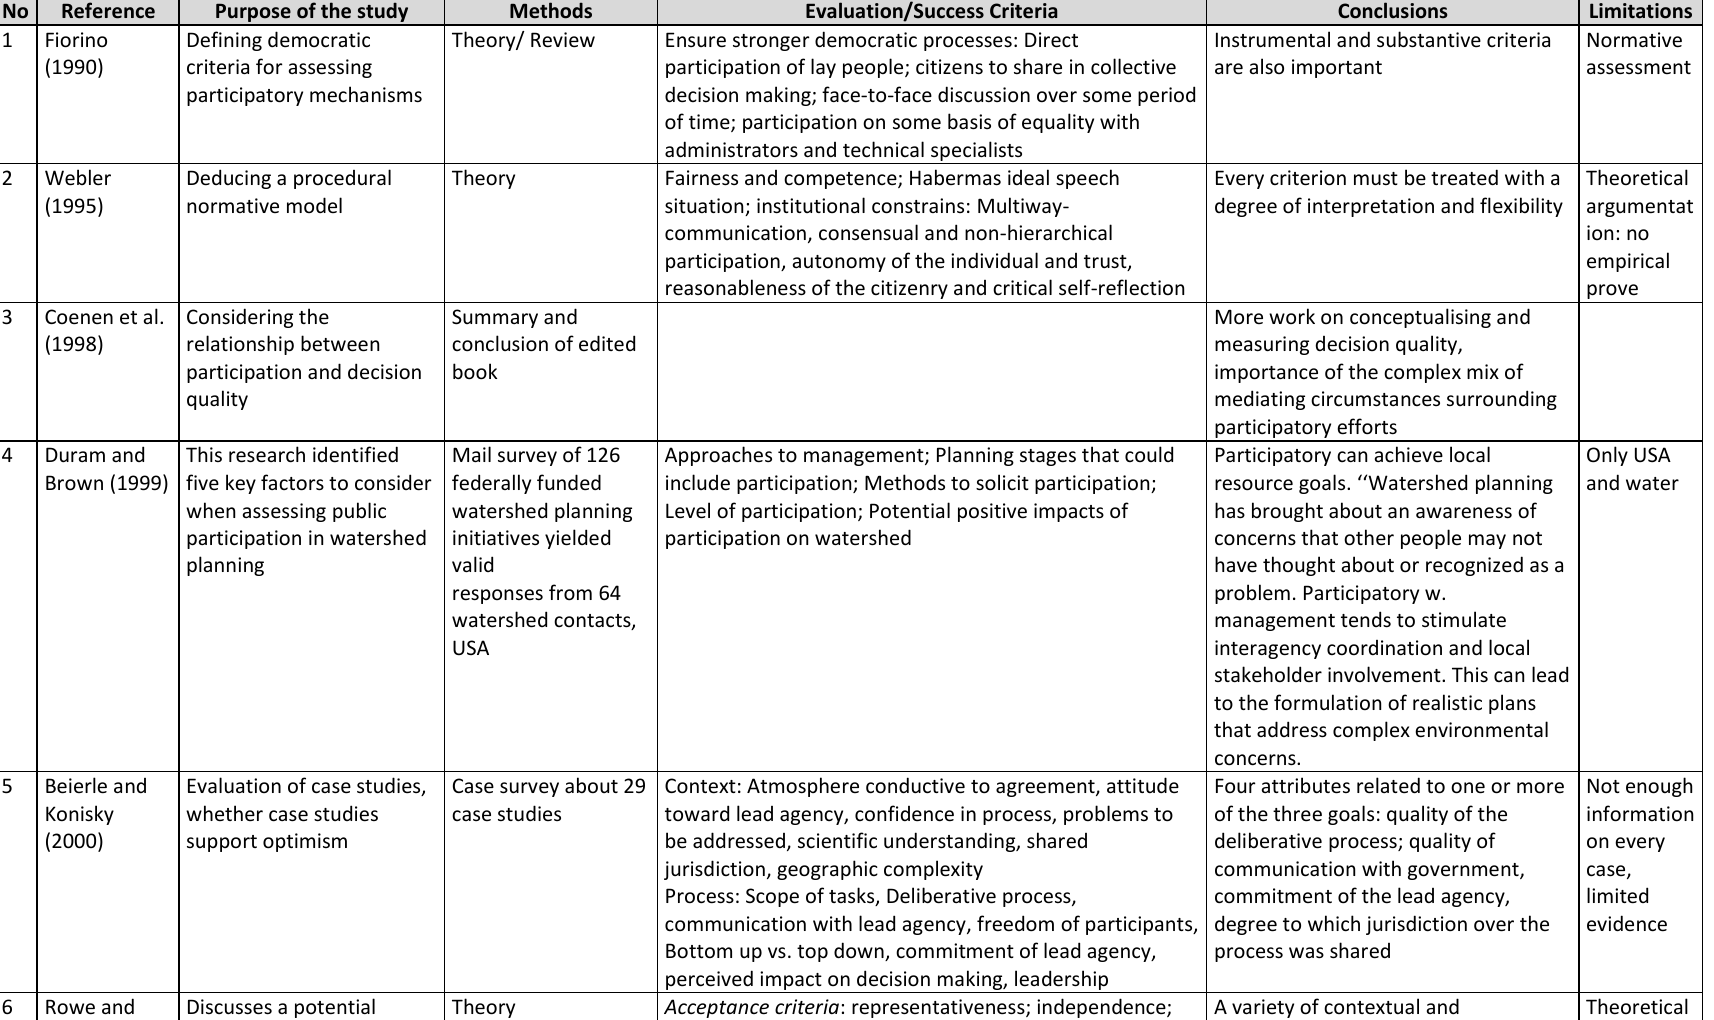
Table 1: Overview Reviewed Literature Evaluation of Participation in Chronical